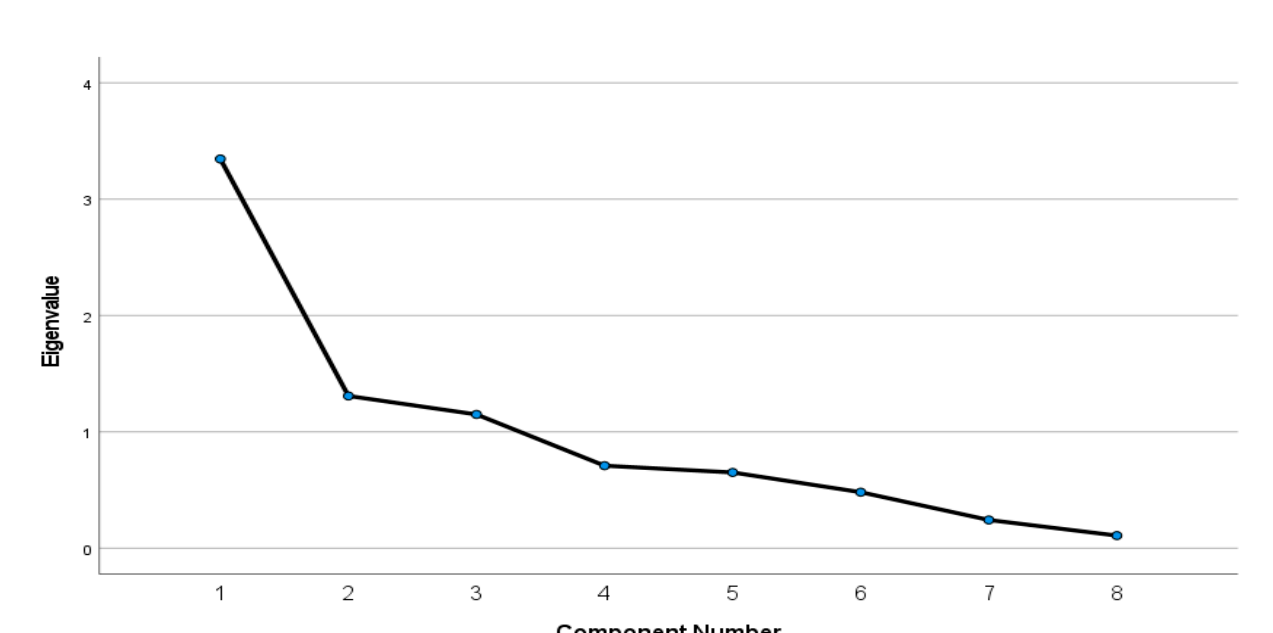
Table 7. Pattern matrix acquired in the principal component analysis regarding barriers to implementing Industry 4.0 solutions.